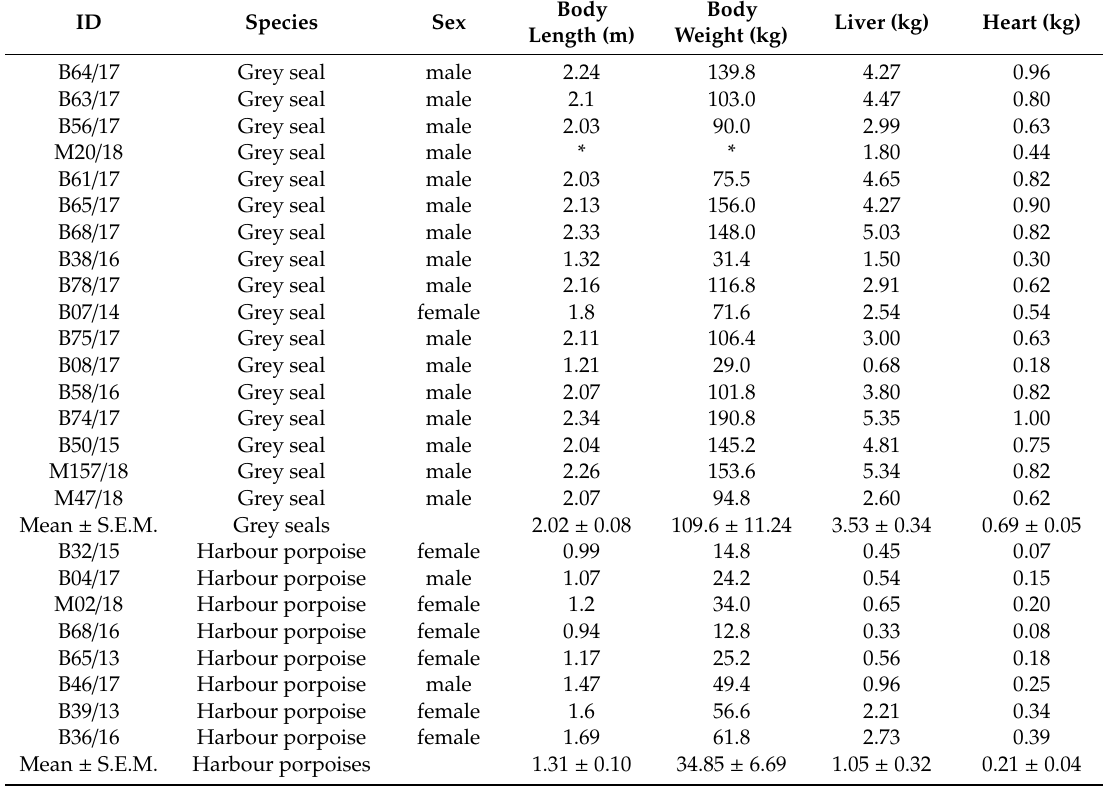
Table 1. Body length and weights of the body, liver, and heart of harbour porpoise and grey seals used in the present study, ID—identification number of stranding scheme.